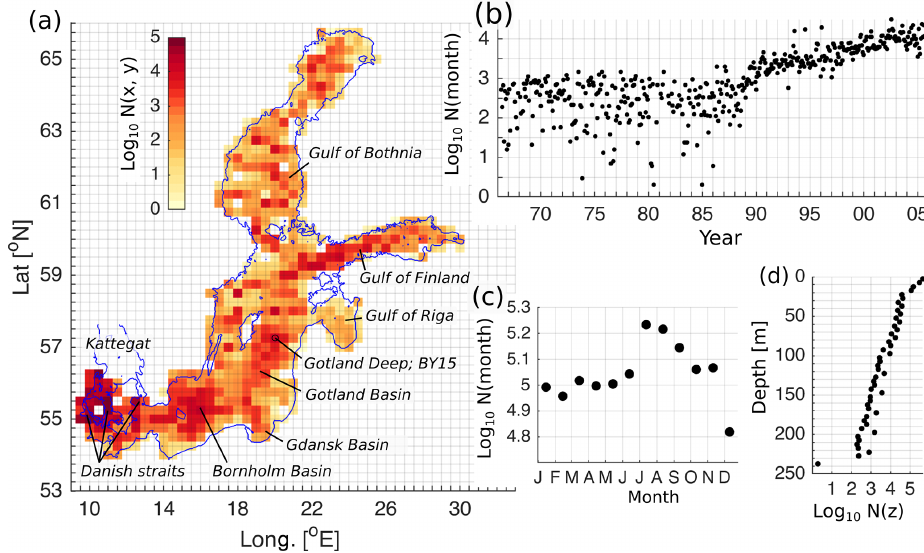
Figure 1. Spatial (a) , temporal (b) , seasonal (c) , and vertical (d) distribution of the number of measurements in the dataset. The horizontal bins have a resolution of 25km × 25km (a) , temporal and seasonal bins have a monthly resolution (b,c) , and vertical bins have a resolution of 5m (d)